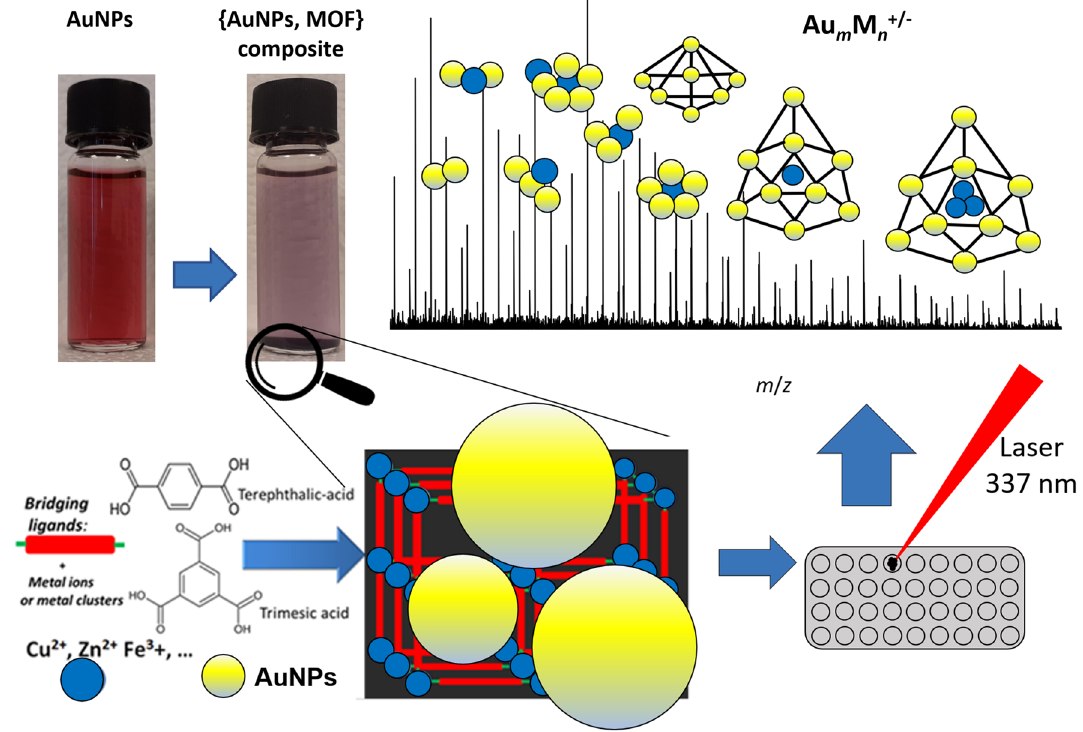
Figure 1. Schematic representation of experimental workflow. Structures have no physical meaning; they are used only for the sake of clarity. The figure was drawn in Microsoft PowerPoint software (version Office365,